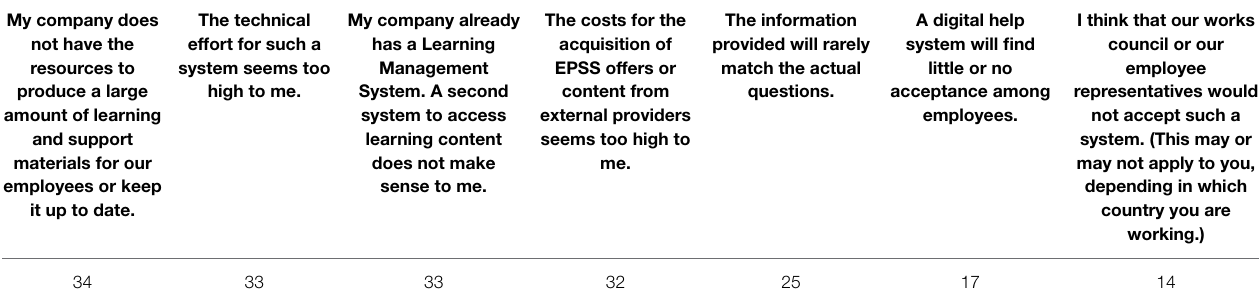
TABLE 4 | Perceived obstacles concerning the implementation and use of EPSS.